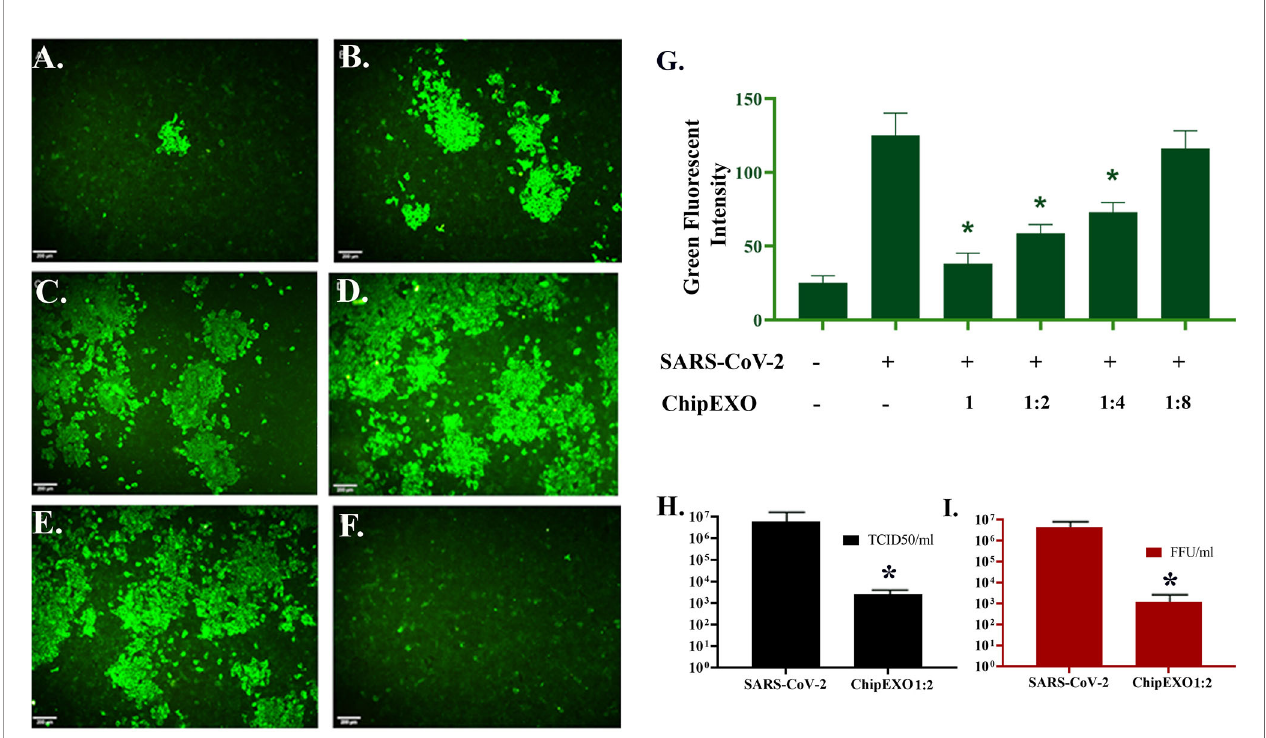
FIGURE 6 | Antiviral activity of ChipEXOs. Undiluted (A) , 1/2 (B) , 1/4 (C) , and 1/8 (D) dilutions of ChipEXOs were mixed with 100 FFU of the SARS-CoV-2 and incubated at 37°C for 1 h. Infected non-treated (E) and mock-infected (F) controls were also included. (G) Bar graphical demonstration of green fl uorescent levels of the virus antigen. (H) Comparison of TCID50 values of the virus-infected control and ChipEXO-treated cells. (I) Comparison of FFU values of virus-infected control and ChipEXO-treated cells. The antibody-labeled cells were detected and analyzed by immuno fl uorescence microscopy (Leica, DFC450C). Scale bars = 200 m m (* p <